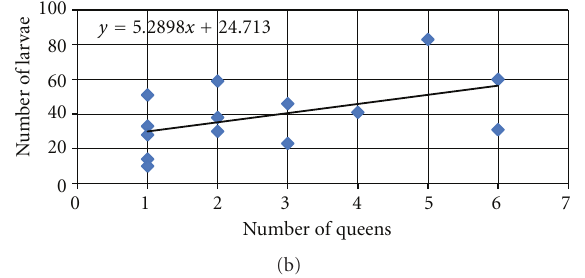
Figure 5: P. ohioensis scatter plot of colonies ( N = 14): (a) workers versus larvae; (b) queens versus larvae.